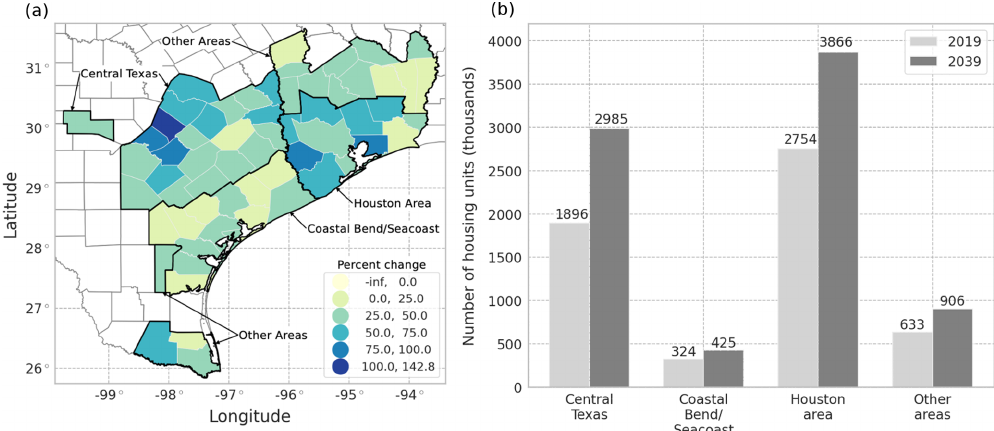
Figure 11. (a) Projected 20-year (2019–2039) percent change in housing units in the Hurricane Harvey-affected region using the REACH20 model. (b) Projected housing units and housing growth rates for the Hurricane Harvey-affected region using the REACH20